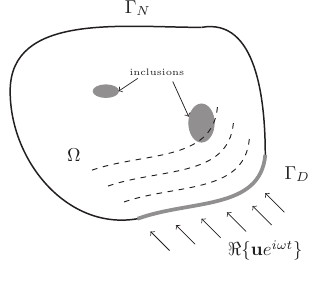
Figure 1. Illustration of the domain and boundary